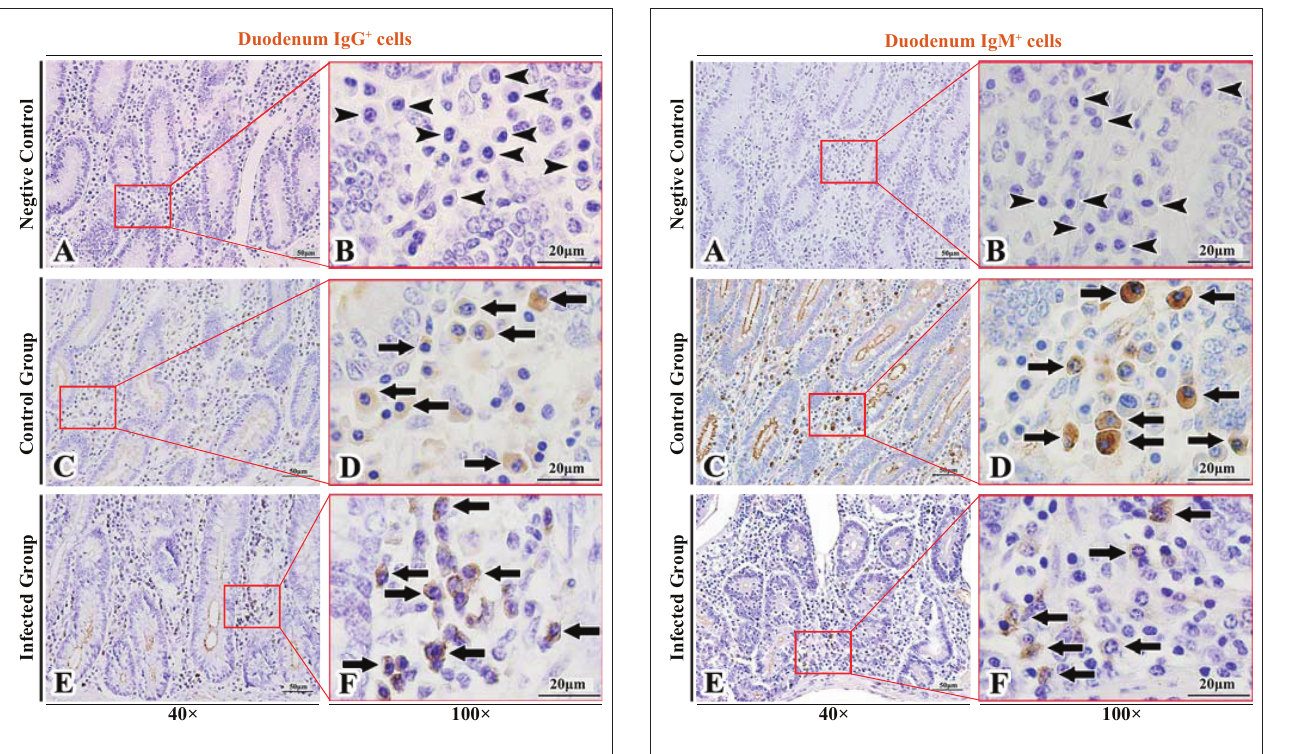
the best working concentration was